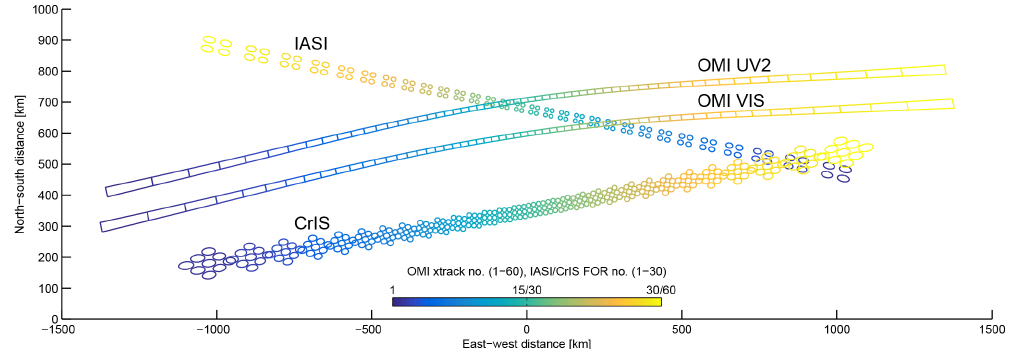
Figure 1. Across-track (xtrack in figure) ground pixel geometry for IASI, CrIS, and the UV2 and VIS (visible) bands of OMI.